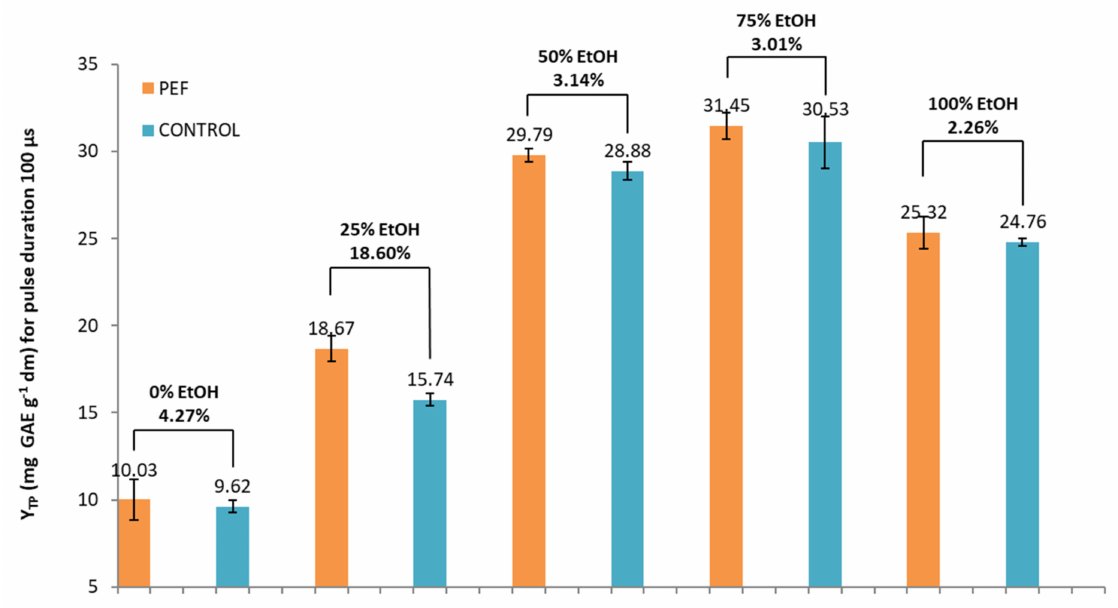
Figure 4. Y TP (mg of gallic acid equivalents (GAE) per gram of dry weight (dw)) for PEF and control samples in five different tested solvents and a pulse duration of 100 µ